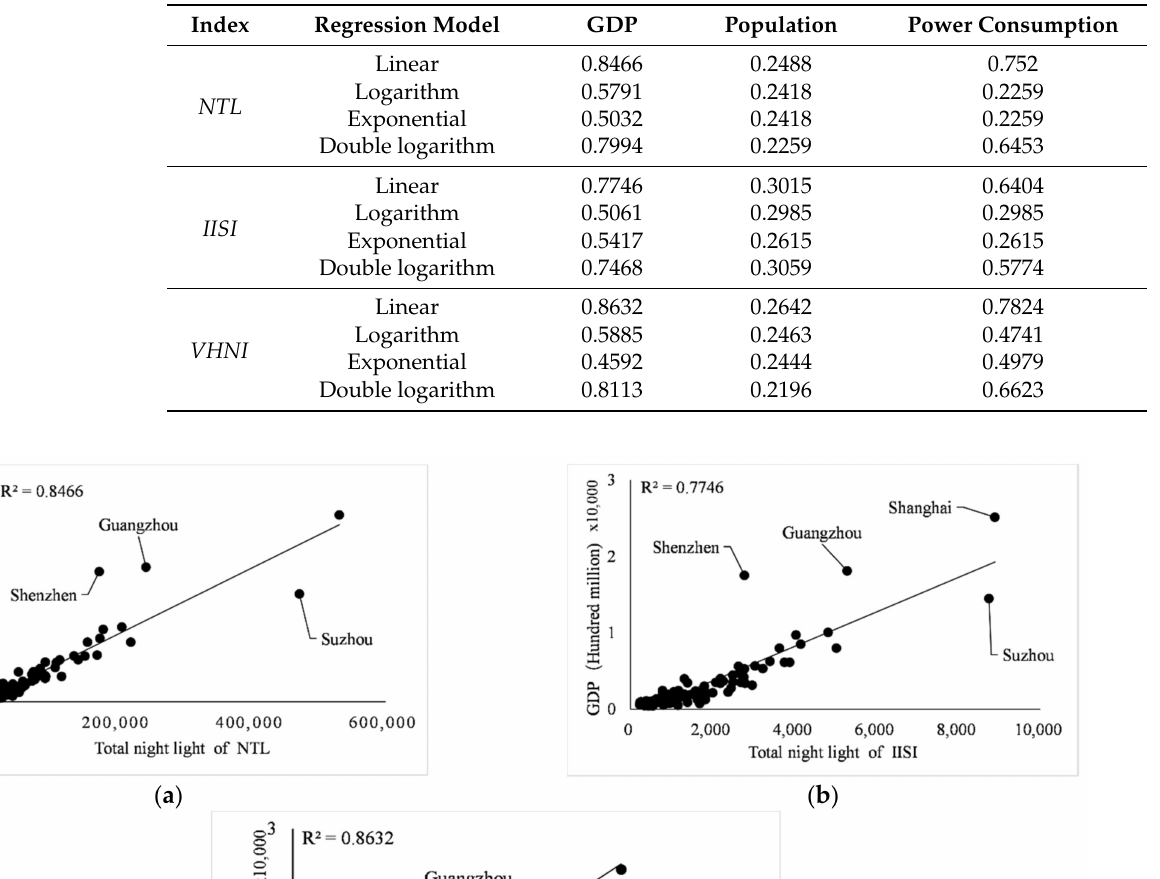
Table 3. Three indices versus three indicators in different regression models.